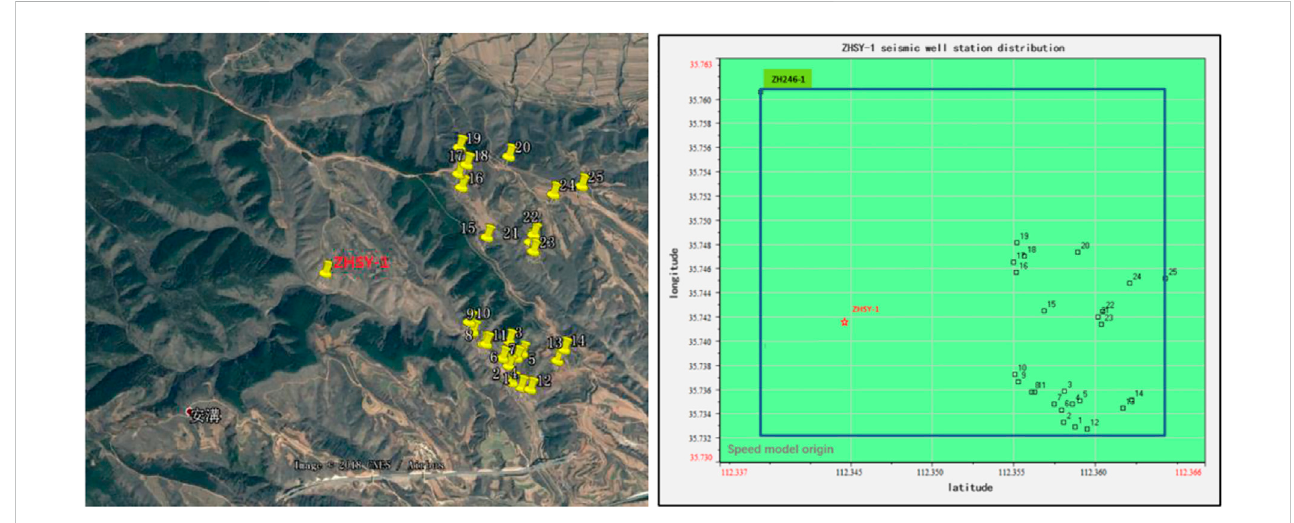
FIGURE 2 Distribution of stations.